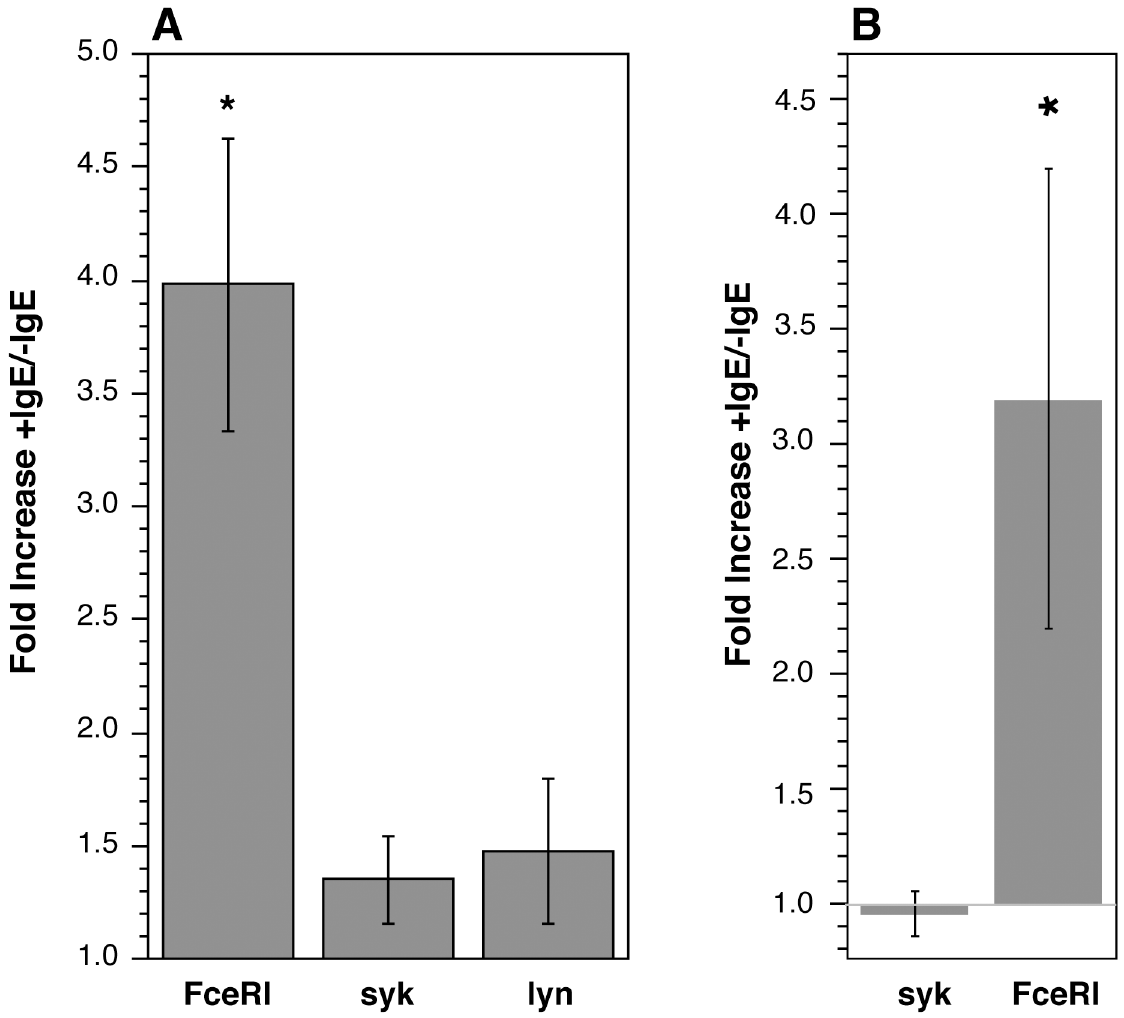
Fig 3. Changes in FceRI, syk or lyn expression during up-regulation of FceRI by culture for 4 days in 5 ng/ml IL-3 ± 1 µ g/ ml IgE. Panel A, peripheral blood basophils(n = 3). Panel B, CD34B starting on day 17 of culture (n = 4).